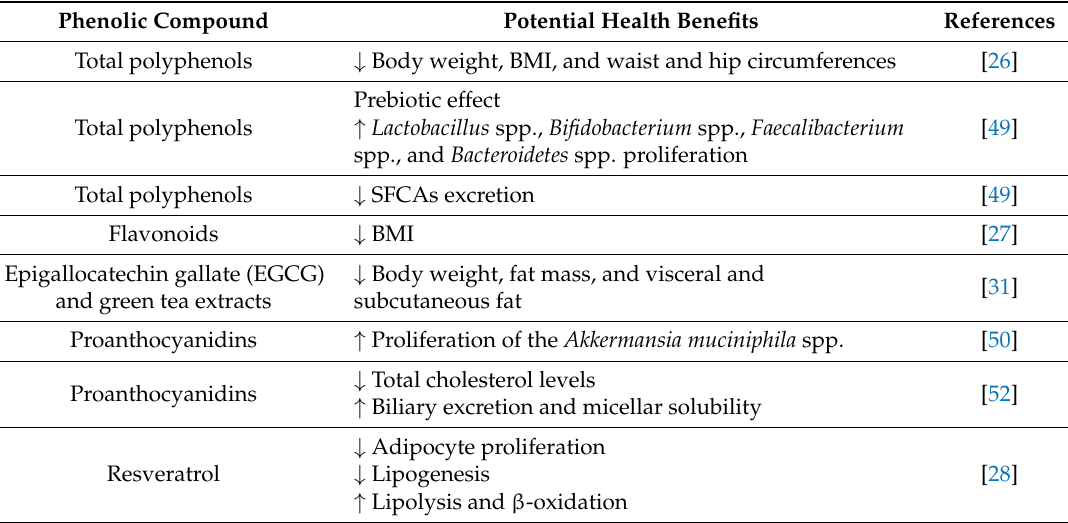
Table 2. Potential health benefits on body weight by Mediterranean diet